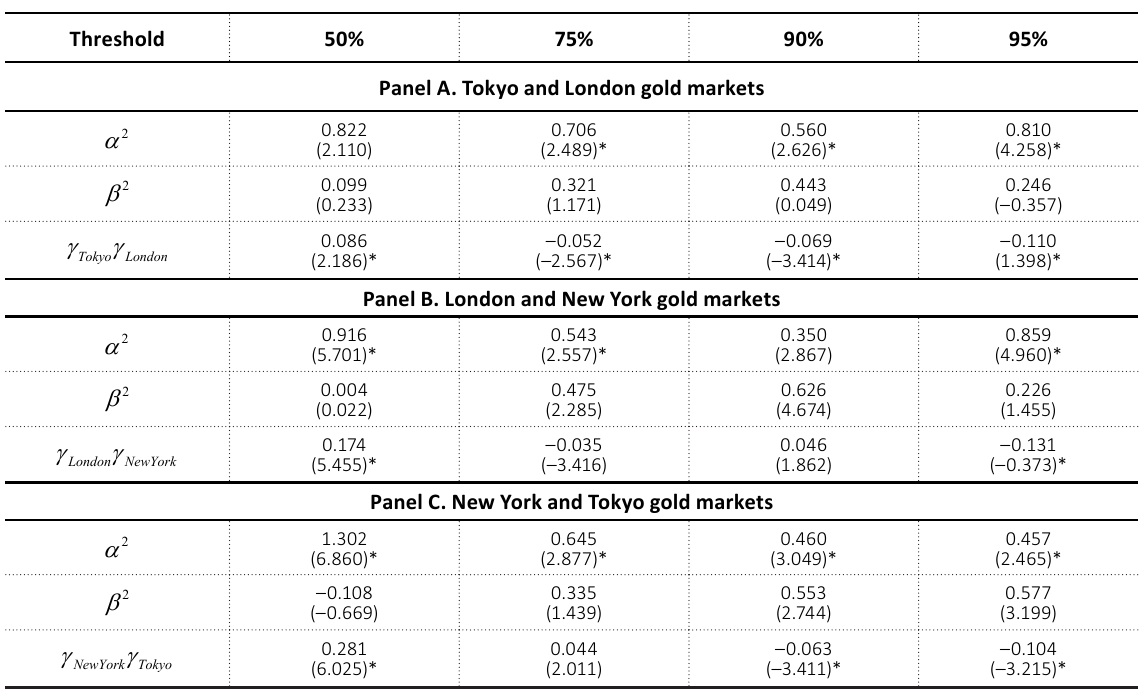
Table 6. Volatility threshold and dynamic conditional correlation a